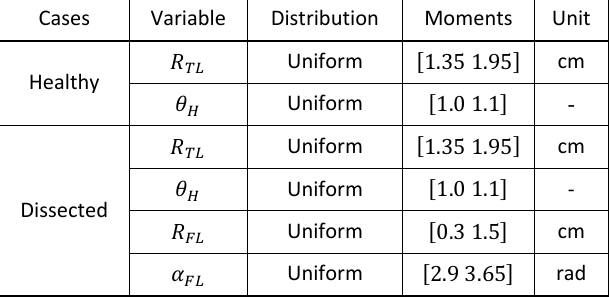
Table.1: Input space description for the healthy and dissected study cases.